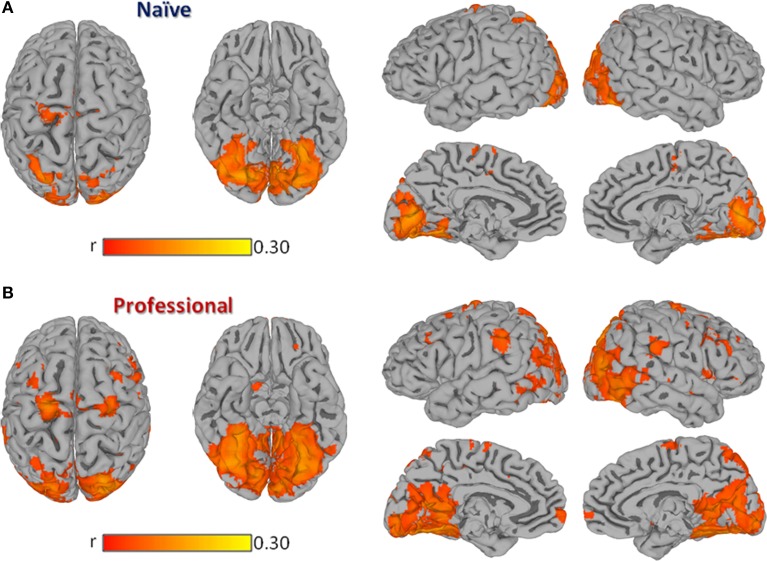
Group Inter-Subject Correlation (ISC) maps obtained by averaging Pearson's correlation coefficients computed between each pair of subjects within the same group at each location. Panel (A) shows the group-level ISC-map obtained in naïve drivers, while (B) shows results obtained in professional drivers. All results are FDR corrected p < 0.001.